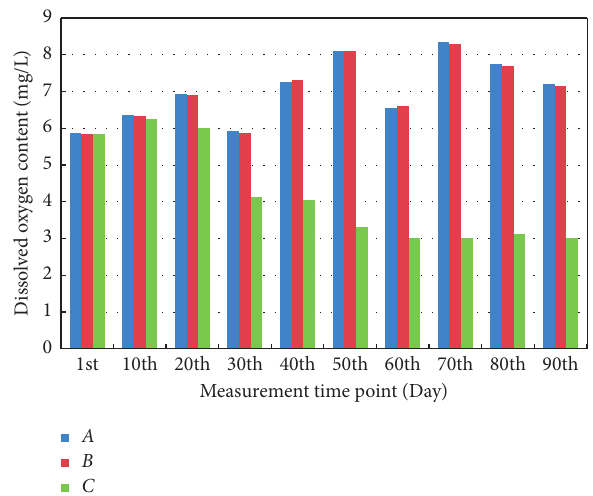
Figure 7: Measurement results of ultrasonic cleaning probe and noncleaning